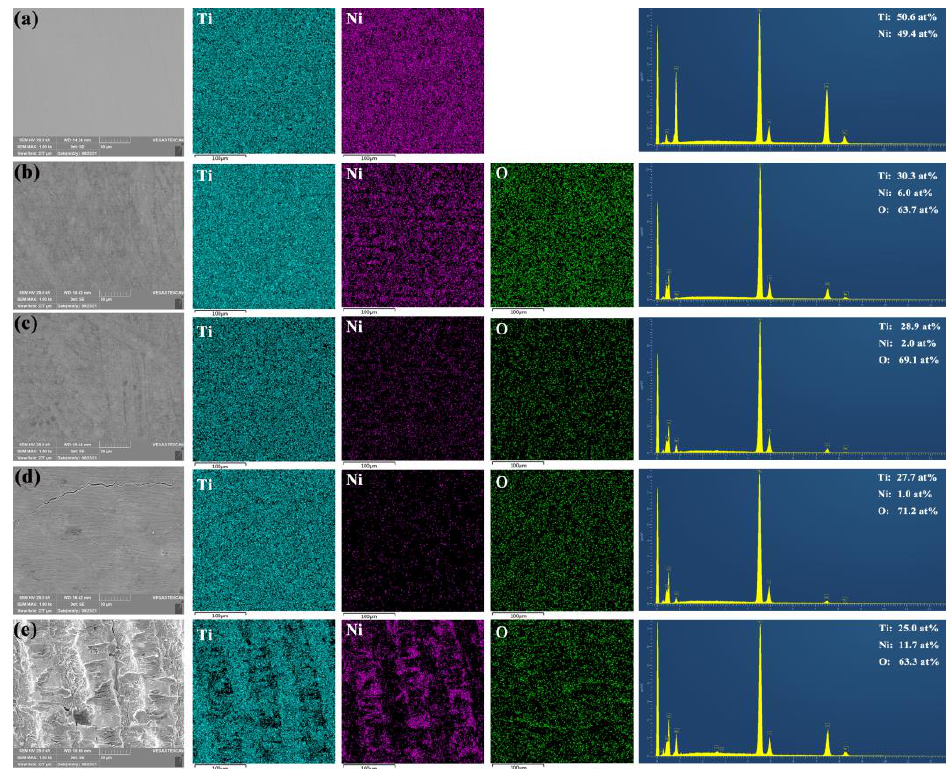
Figure 5. SEM image of samples before and after femtosecond laser ( a ) As-fabricated ( b ) 10 μm.